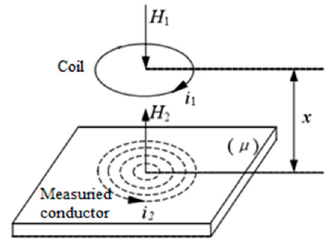
Figure 2. The eddy current reaction.